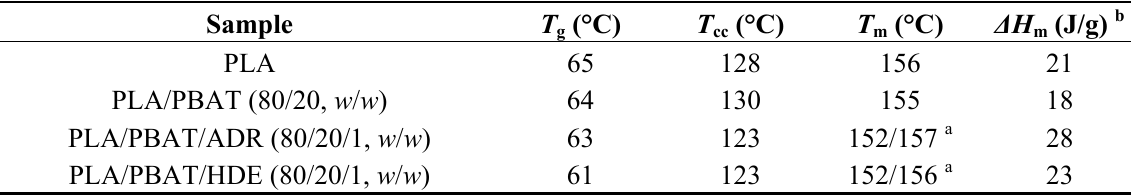
Table 2. Thermal properties of the PLA and PLA/PBAT blends with different types of chain